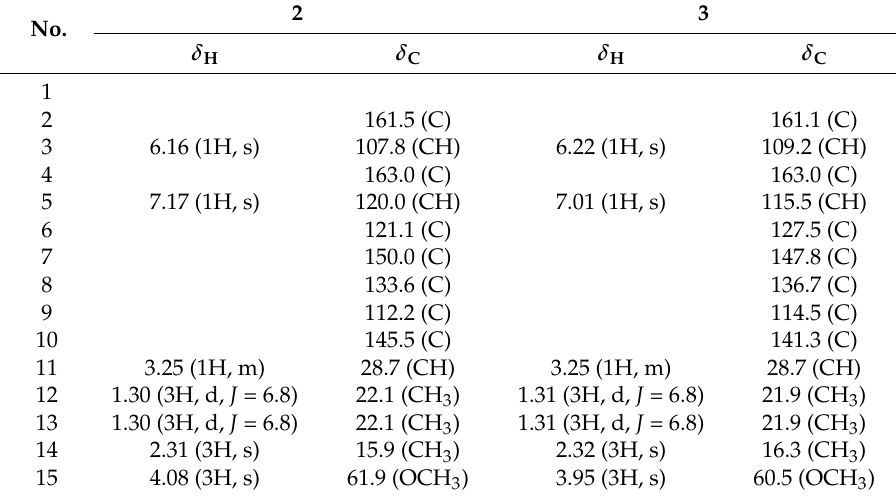
Table 2. NMR data for compound 2 and 3 (TMS as the internal standard, δ in ppm, J in Hz) a .